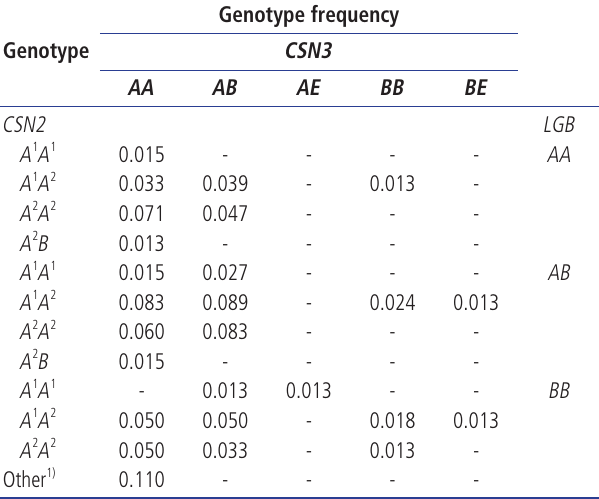
Table 3. Frequency distribution of the investigated milk protein genotype combinations of CSN2 - CSN3 - LGB (with frequency equal or higher then 0.013) Genotype